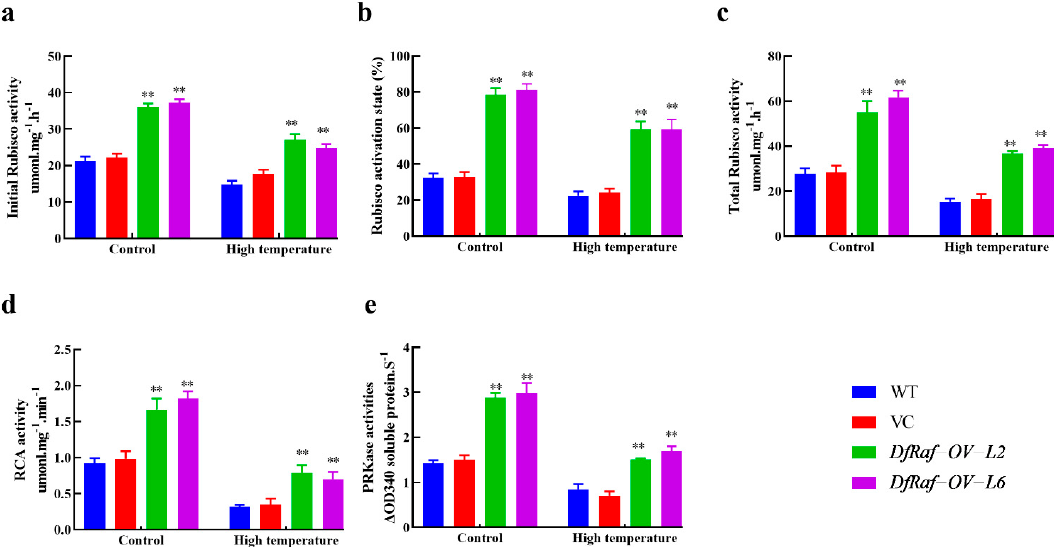
Figure 10. Effects of high-temperature stress on carbon assimilation enzyme activity in the leaves of DfRaf overexpression lines. Effects of high-temperature exposure on total Rubisco activity ( a ), initial Rubisco activity ( b ), Rubisco activation state ( c ), RCA activity ( d ) and PRK activity ( e ) in the leaves of DfRaf overexpression lines. Each bar in the graph corresponds to the mean value ± SD of three independent replicates. ** p < 0.01.